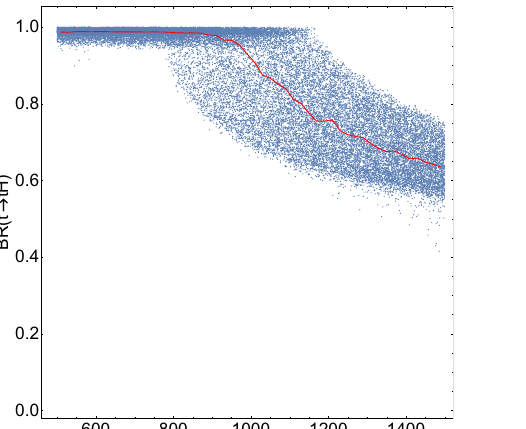
! Ht and H ! (cid:13) (cid:13) as a function of the 0